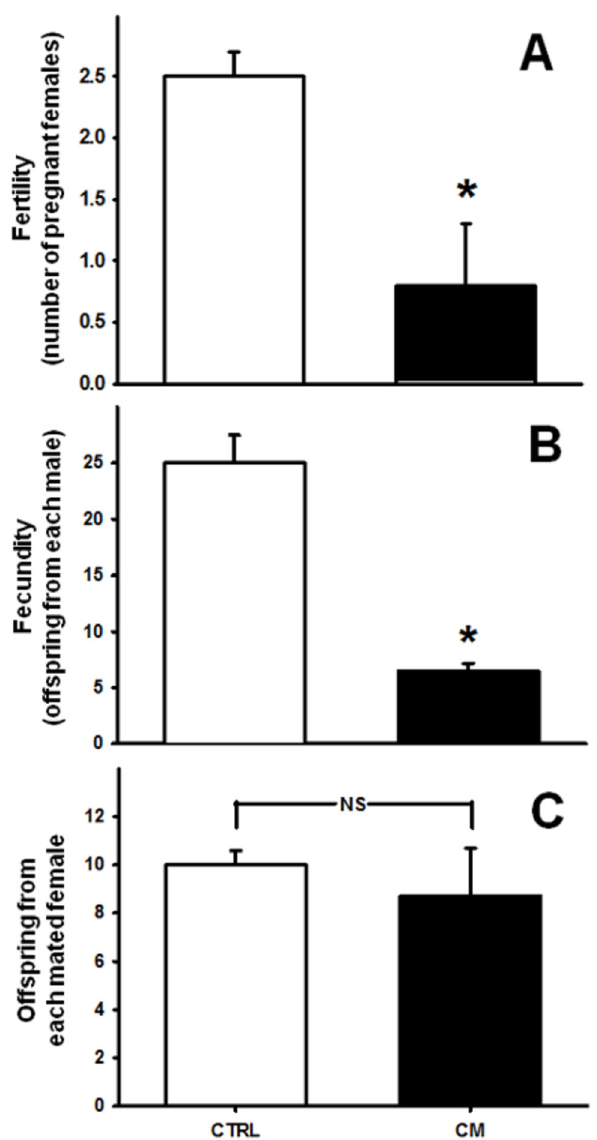
Figure 1. Chronic malnutrition-induced alterations in the reproductive profile of adult male rats. The animal groups were well-nourished rats (CTRL) and chronically malnourished rats (CM), as indicated on the abscissa . (A) Fertility: number of well-nourished pregnant females resulting from mating with one well-nourished (empty bar) or one chronically malnourished (black bar) male. Data are represented as mean ± SEM of matings from six groups (1 male with 3 females each) of CTRL and CM rats. (B) Fecundity: offspring from each CTRL or CM male rat. Data are represented as mean ± SEM of offspring from six mated groups. (C) Offspring from each mated female. Results are mean ± SEM from 18 dams. *P<0.05 vs. the corresponding CTRL (unpaired Student’s t -test); NS: no statistical